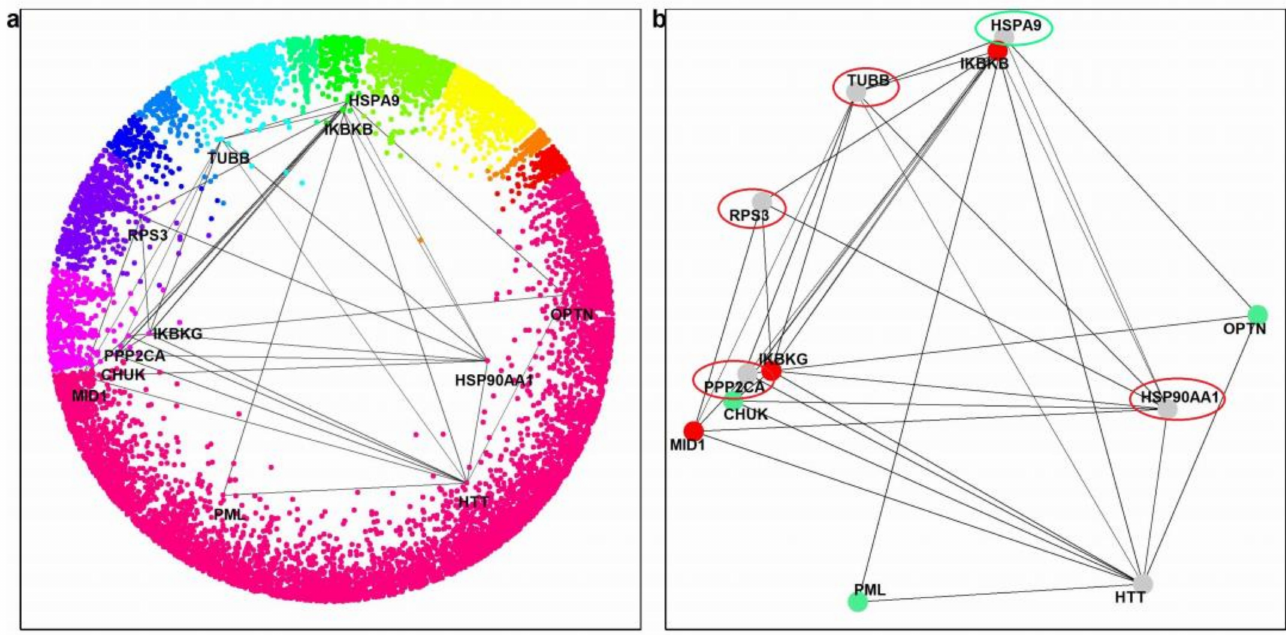
Figure 4. Positive and negative effectors on HD and closely connected components. ( a ) Position of the positive and negative paralogs and their common interacting partners in the hyperbolic disc. ( b ) Red nodes represent the negative paralogs, and the nodes surrounded by the red ellipses are their common interactors. Green nodes represent the positive paralogs, and the node surrounded by the green ellipse represents their common interactor.